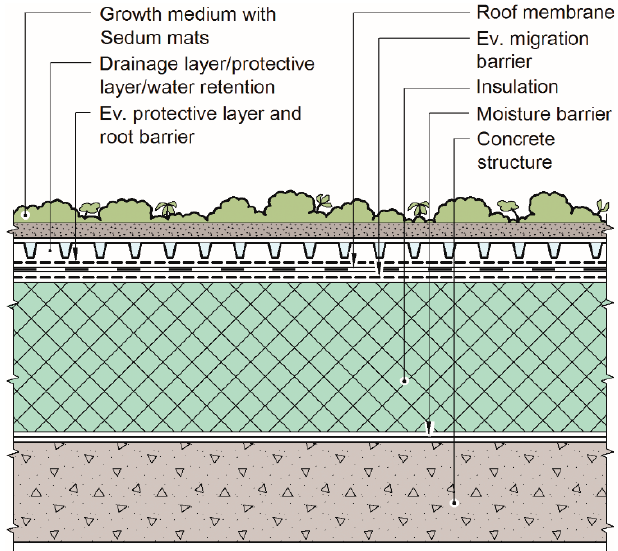
Figure 1. Example assembly of a blue-green roof mounted on a conventional, compact roof. Green roofs may be built for several purposes other than urban stormwater manage- ment. Their purpose may also be to add green space to urban areas, or for energy savings in warm climates. The various benefits of green and blue-green roofs have been reviewed by several authors [16–20].